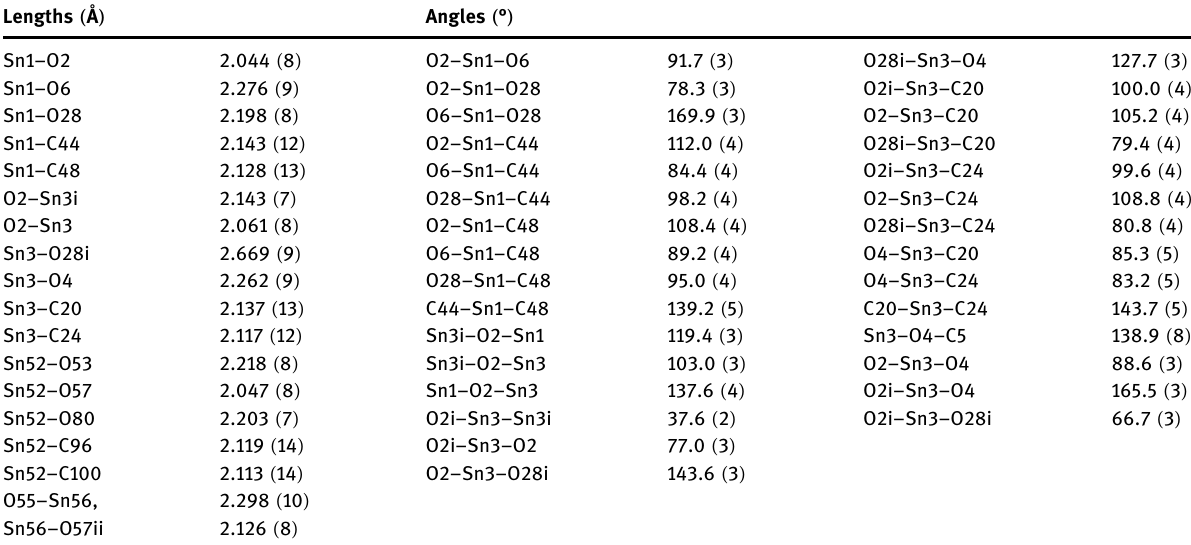
Table 4: Geometric parameters ( Å and ° ) of complex 2 Lengths ( Å ) Angles ( °